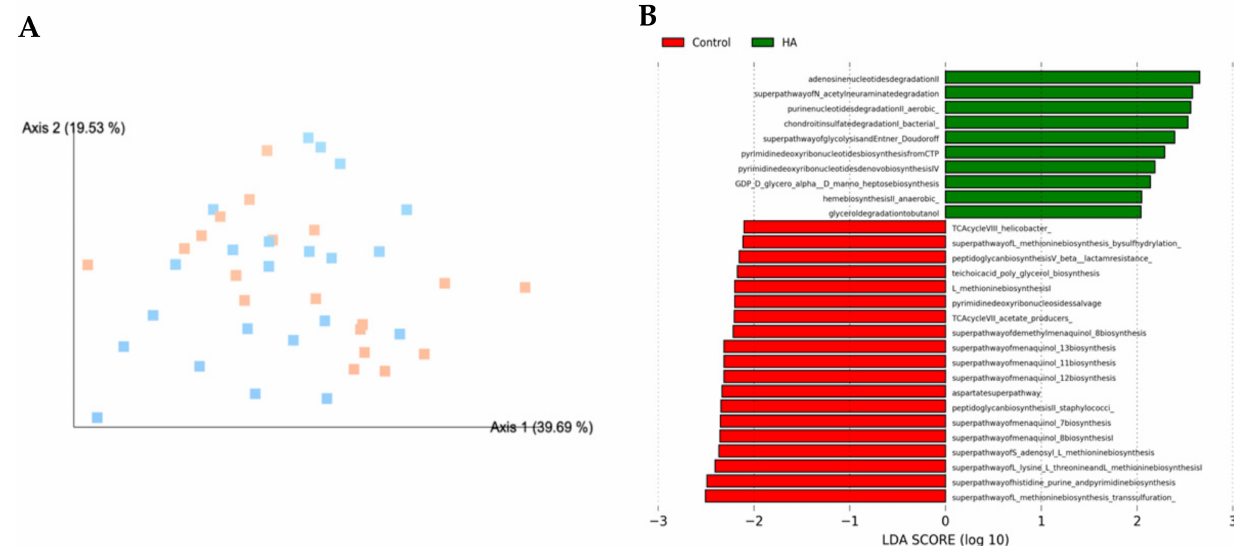
Figure 6. PICRUSt2 functional prediction. ( A ) PCoA plot displaying Bray Curtis beta diversity matrix calculations (Control = orange; HA 35 KDa = blue). Percent confidence values for each distance matrix are displayed on the axes in two dimensions. PERMANOVA results: F = 1.80; p = 0.1. ( B ) Predicted metabolic pathways statistically attributed to the experimental variable. PICRUSt was used to predict the functional potential of microbiomes using 16S rRNA gene sequence data. Red bars represent controls; green bars represent HA 35 KDa-treated pups. HA: hyaluronic acid; PCoA: principal components analysis; LDA = linear discriminant analysis; PICRUSt = Phylogenetic Investigation of Communities by Reconstruction of Unobserved States.